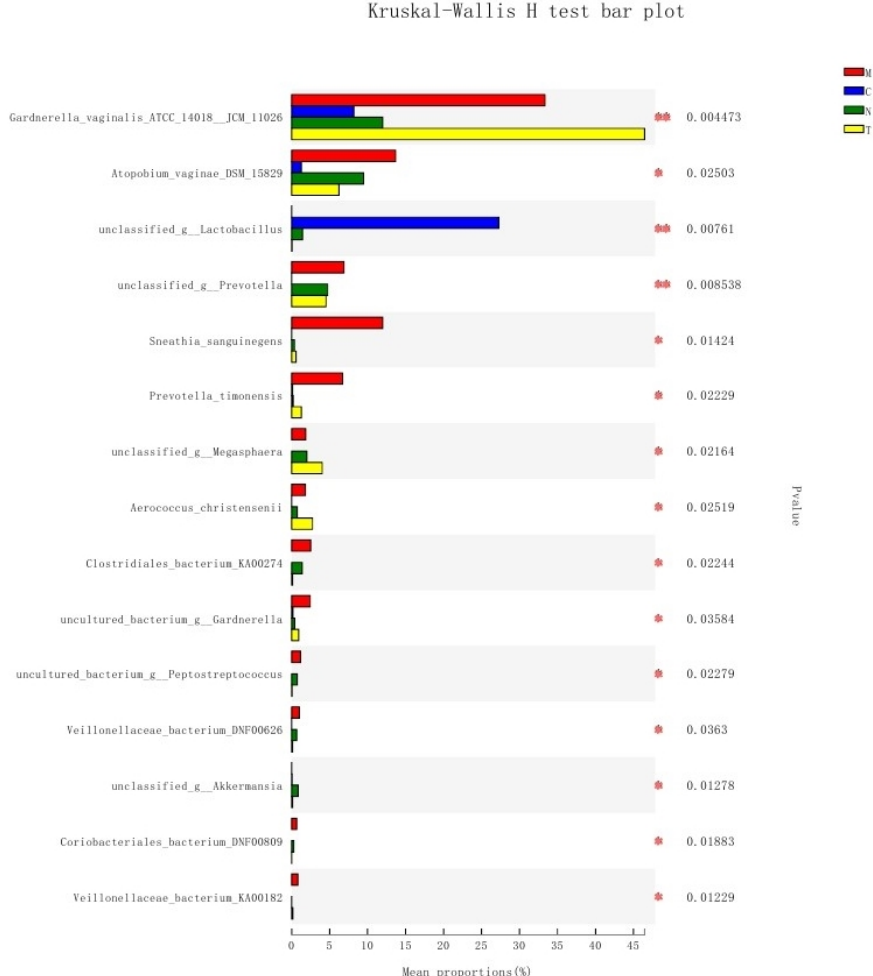
Figure 5. Distribution of bacterial communities in the four groups, with the average relative abun- dances of species in different groups plotted on the x -axis and species names plotted on the y -axis. Different colored columns indicate different groups. * 0.01 < p ≤ 0.05, ** p ≤ 0.01.